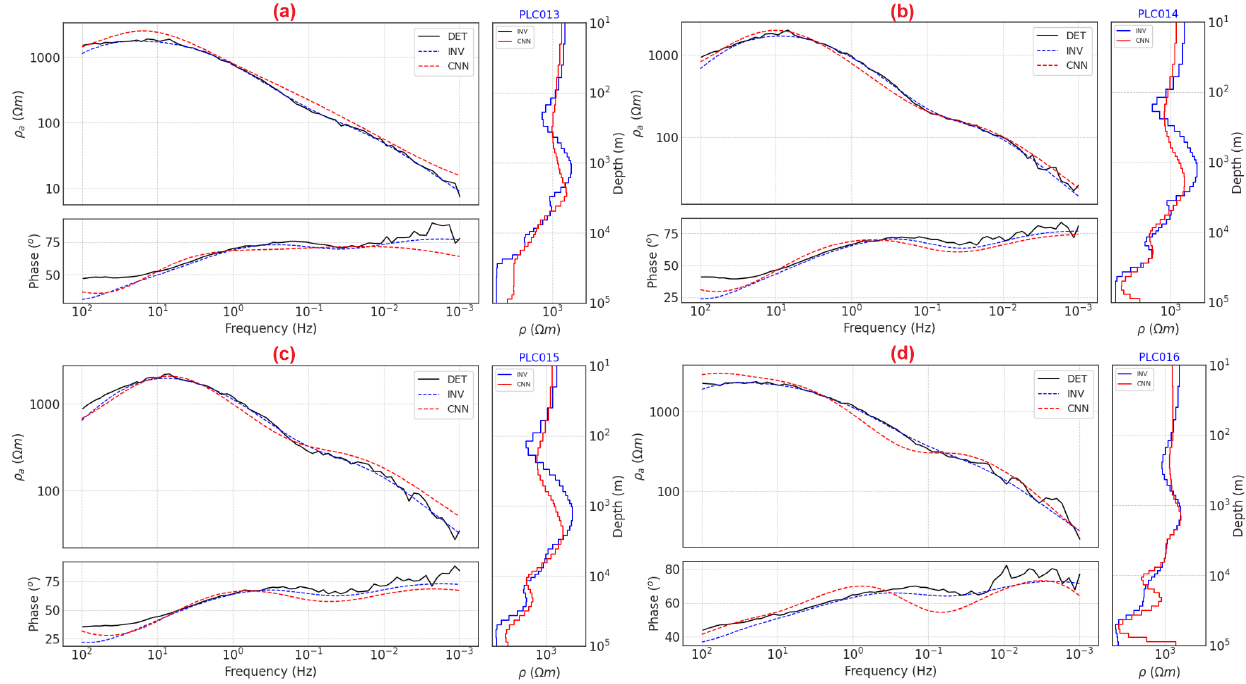
Figure 9. The plots of selected sites: ( a ) site PLC013, ( b ) site PLC014, ( c ) site PLC015, and ( d ) site PLC016. In the subplot of each site: left top panel: comparison of apparent resistivity between the determinant and 1D modeling response; left bottom panel: comparison of phase between determinant and 1D modeling response; right panel: predicted resistivity with a CNN model and traditional iterative